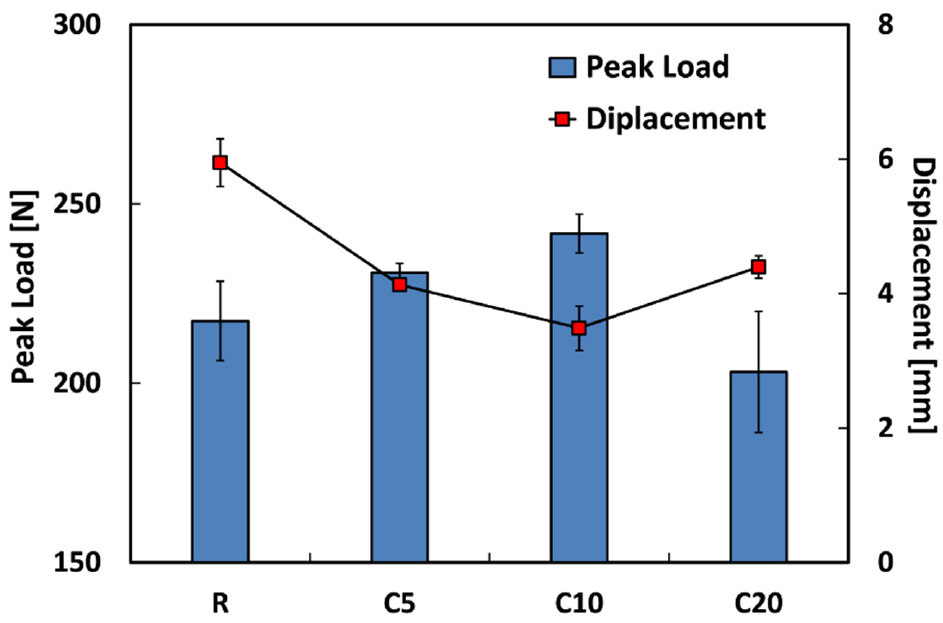
Figure 6. Peak load and maximum displacement values of flax fiber reinforced composites for each treatment condition.